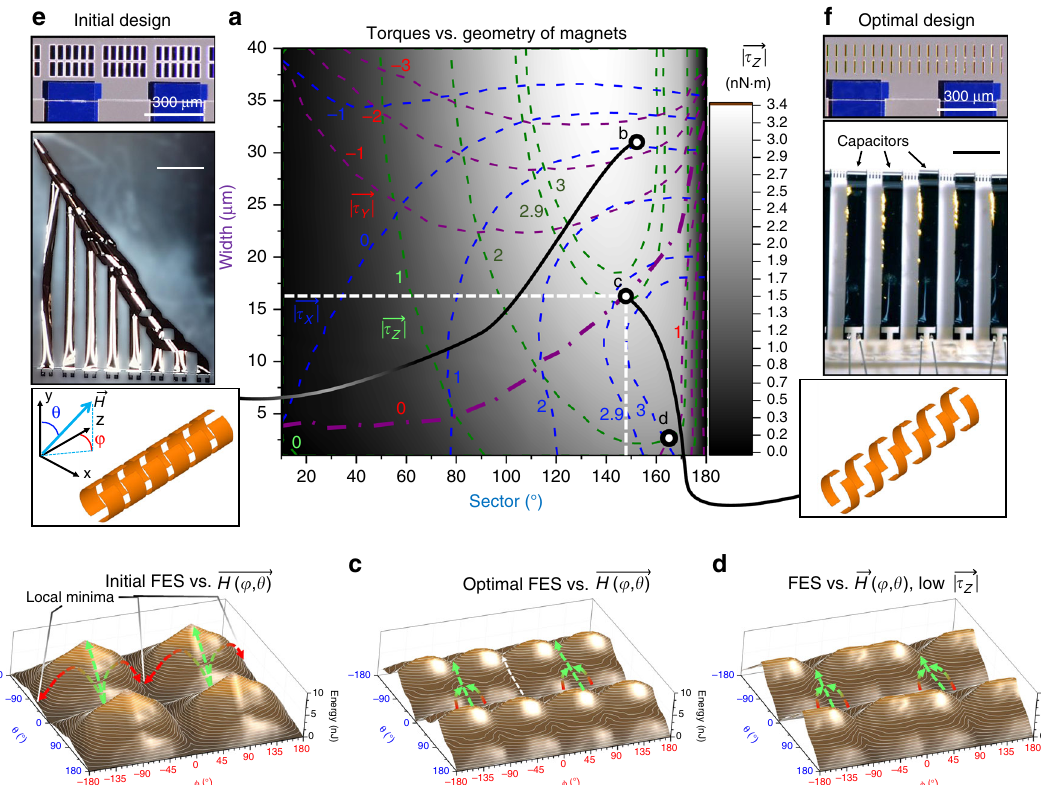
Fig. 5 Shape-dependent behaviour of magnetic rotor in a rotating magnetic fi eld. a Magnetostatic torque map in coordinates of the rotor magnet geometry ! generating points for the initial design (b), an optimal design (c) of the magnets and a design with good assembly behaviour but low τ z . b Free energy landscapes (free energy surfaces (FES)) of an initial design with characteristic hills and energy minima and potential relaxation pathways of the rotor aligning the structure ’ s z- axis along the fi eld. Green arrows show the pathways the structures have to follow during rotation of the magnet. Red arrows show misaligning relaxation pathways. c , d FES of best designs with characteristic energy minima and potential relaxation pathways of the rotor aligning the ! structure ’ s y axis always along the fi eld. For d , τ y is 30% smaller, which has a direct impact on the maximum rolling length. Green lines on the FES represent rotation pathways for the tube driven by an external motorized magnet. White arrow shows another possible stable position, but it is inaccessible as the initial orientation of the magnetic fi eld is 90°. e Misassembly with non-optimized shape of magnetic stripes due to torque that aligns the tube along ! the fi eld. f Magnetic Origami of capacitor array with optimal shape of magnetic stripes where τ y aligns the structure perpendicular to the fi eld. e , f Scale bars are 500 μ